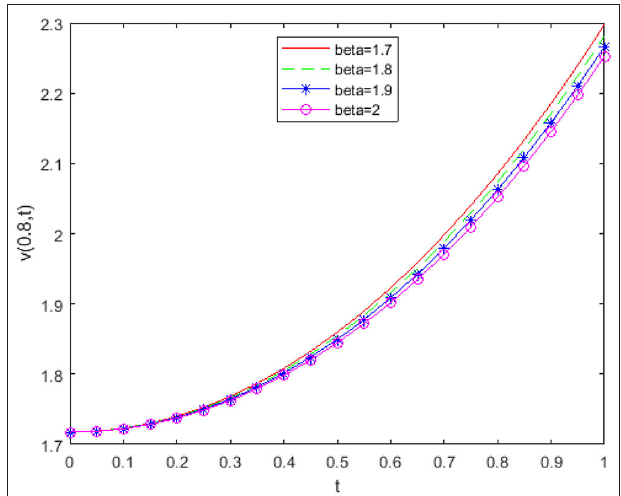
FIGURE 3 | Approximate solution at different values of t and β at x = 0.8.